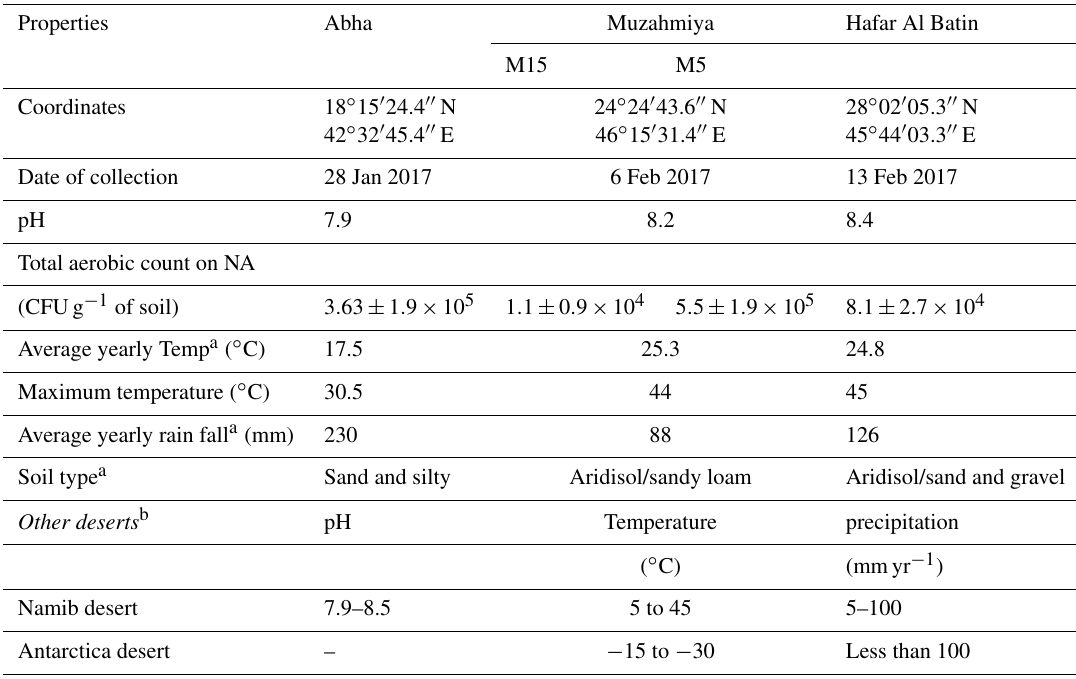
Table 1. The properties of soil samples collected for the study.